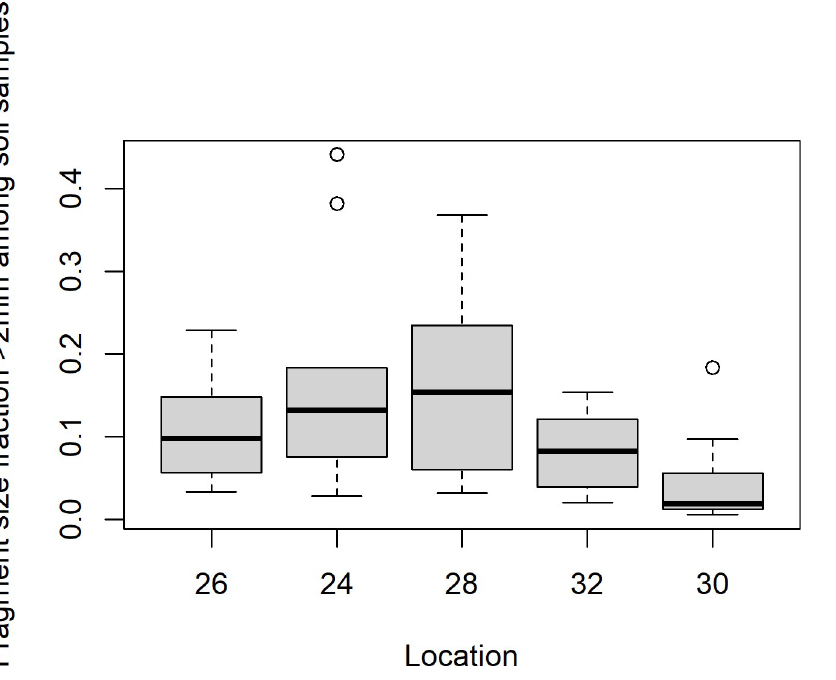
Fig 3. Boxplot of size fraction > 2 mm of soil samples among localities within Mining hill.